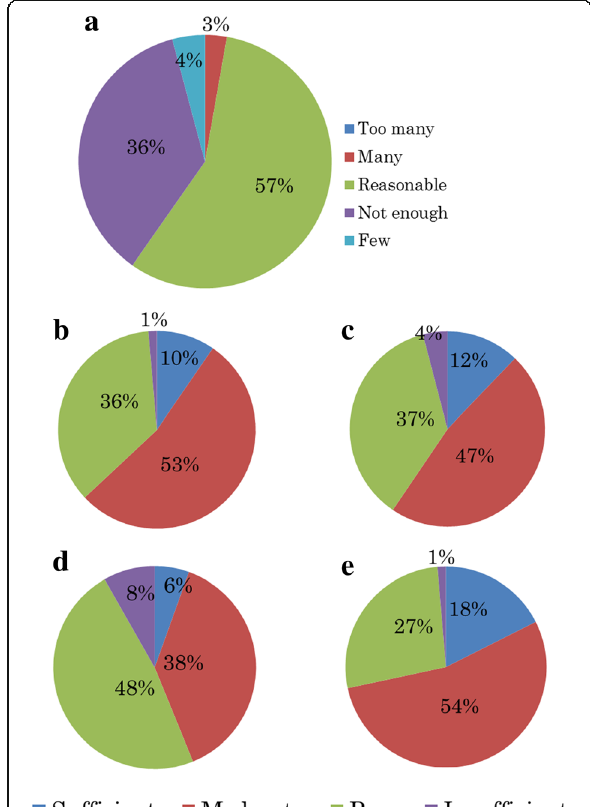
Fig. 4 Research results in the satisfaction with present Kampo related education. a . The number of lectures in the curricula. Forty-one of 72 schools (57%) answered that the number of lectures in the curricula was reasonable. b . Education regarding Kampo related crude drugs and their extracts. Forty-six of 73 schools (63%) answered that the education was adequate. c . Education regarding the basics of Kampo medicine (features, technical terms, and core concepts, among others). Forty-four of 74 schools (59%) answered that they were adequate. d